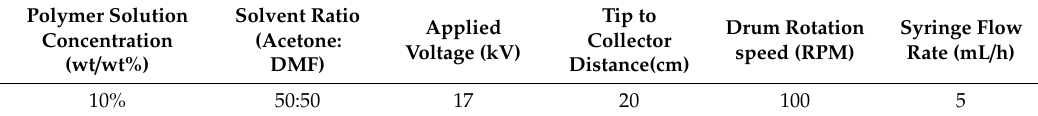
Figure 1. Schematic of syringe pump electrospinning station with rotating cylindrical collector. Table 2. Electrospinning conditions of polyvinylidene fluoride (PVDF) fibers.